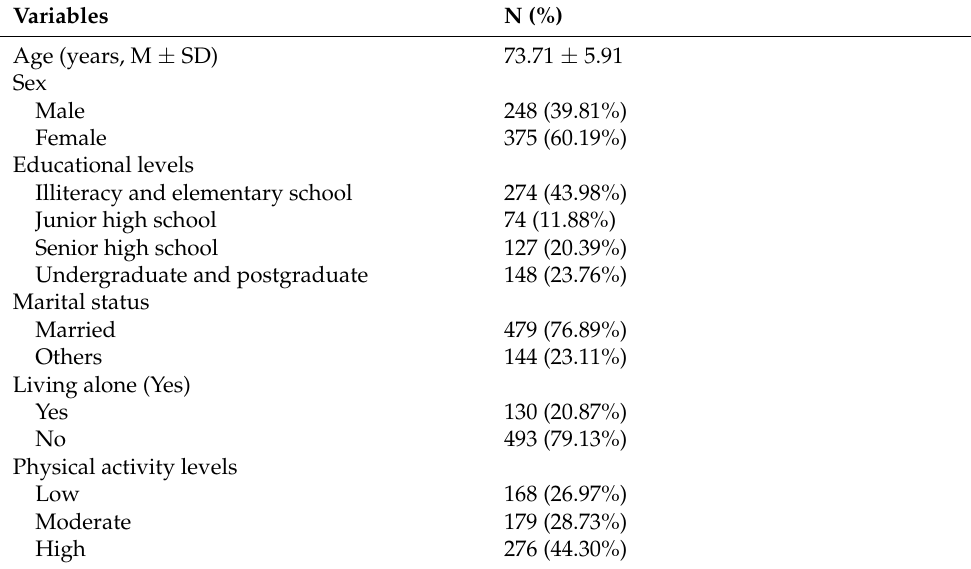
Table 1. Demographic characteristics of the participants (N = 623).